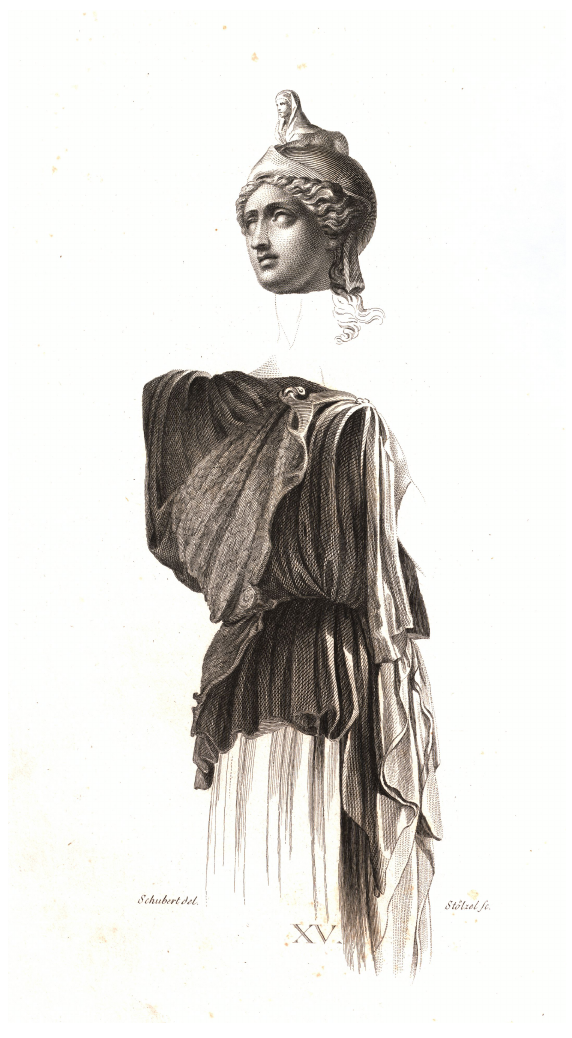
Restaurated statue, from: Becker, Augusteum, plate XV (photo: